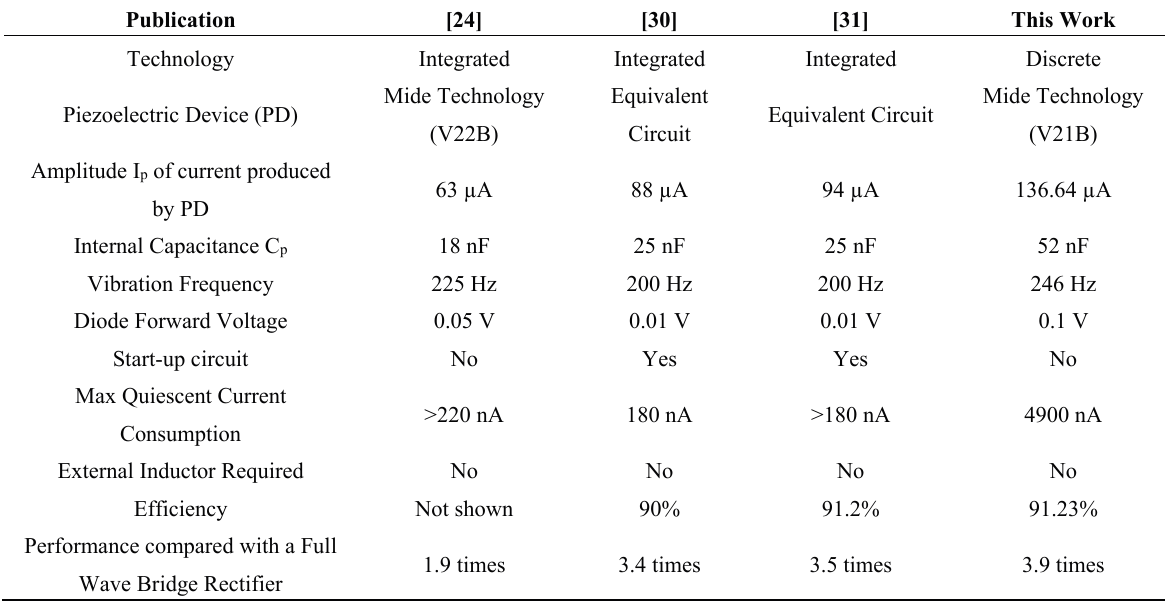
Table 1. Performance comparison with inductorless rectifiers for piezoelectric energy